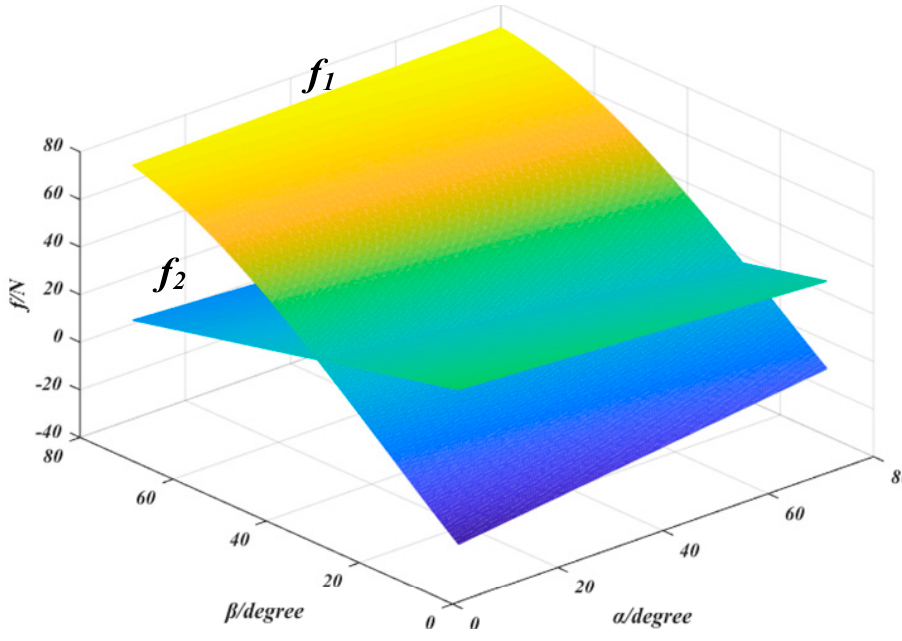
Figure 13. Grasping forces under the PASA mode.